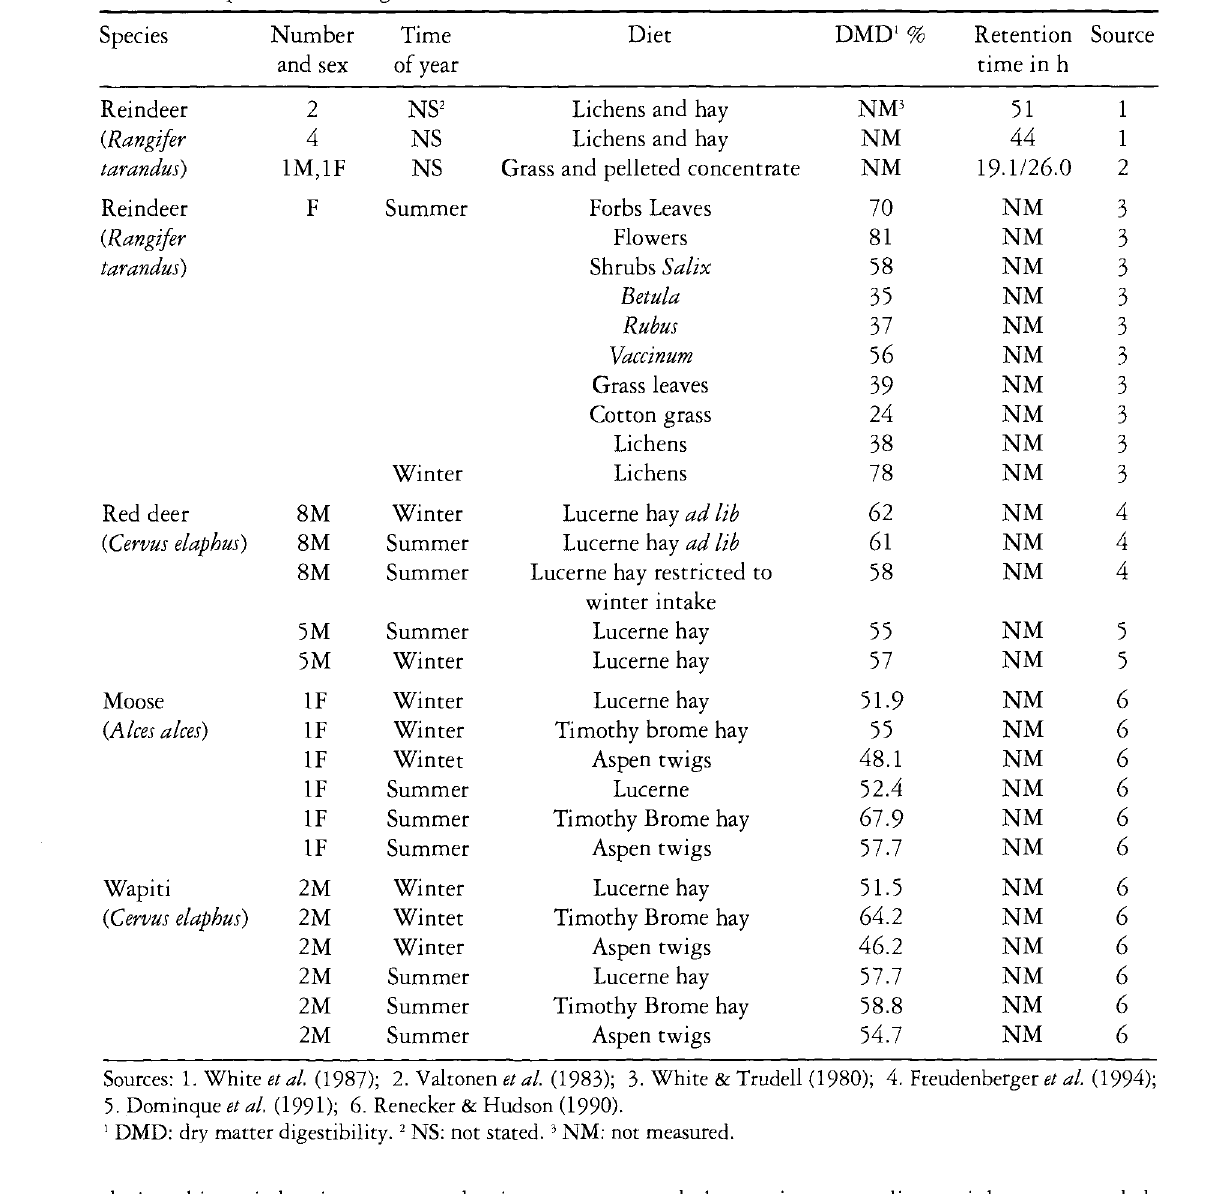
Table 9. Comparison of feed digestion in Cervidae. Species Number Time Retention Source